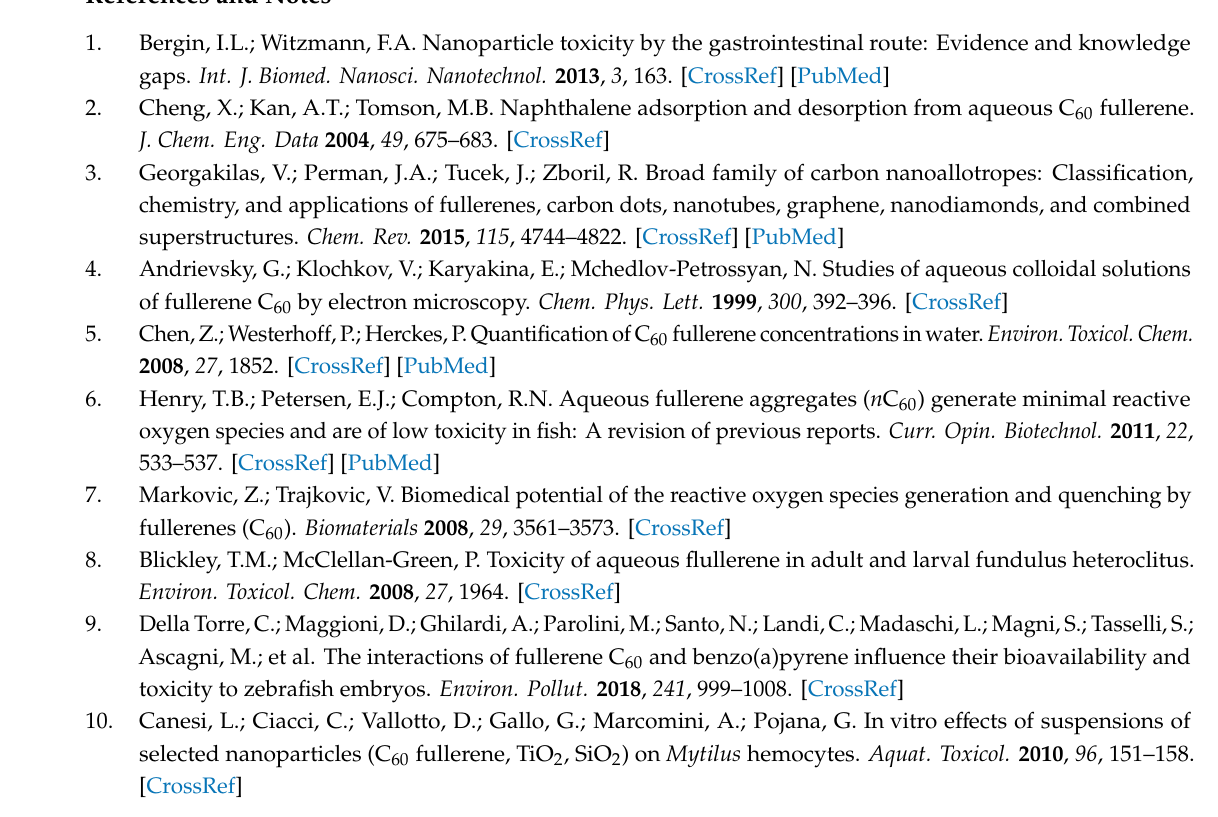
Figure S1: (a) bright-field TEM and (b) intensity-weighted particle size distribution of nC60 aggregates present in mussel-exposed seawater, Figure S2: (a) bright-field TEM and (b) point EDX spectroscopy analysis of Er 3 N@C 80 , Figure S3: Dark-field STEM and EDX spectroscopy mapping analysis of Er 3 N@C 80 , confirming the necessity for spectroscopy to confirm the presence of labelled fullerenes, using the characteristic X-rays emitted from Er upon electron irradiation, Figure S4: (a,c,e) dark-field STEM and (b,d,f) corresponding point EDX spectroscopy analysis of cross-sections of mussel digestive gland exposed to Er 3 N@C 80 , Figure S5: Volcano plots representing the di ff erentially expressed proteins with exposure to B[a]P, C 60 or a mixture of the two (5–50–100 µ g / L B[a]P, 1 mg / L C 60 ), Table S1: The influence of benzo[a]pyrene (B[a]P) of the hydrodynamic diameter (d H ) of n C 60 in mussel-exposed seawater as determined by DLS, Table S2: The concentration of B[a]P in seawater at T0, day 1 and day 3, Table S3: The concentration of nC 60 in seawater at T0, day 1 and day 3, Spreadsheet S1: Full list of DEPs, enriched Gene Ontology (GO) terms and KEGG pathways, R script S1: R script used for proteomics